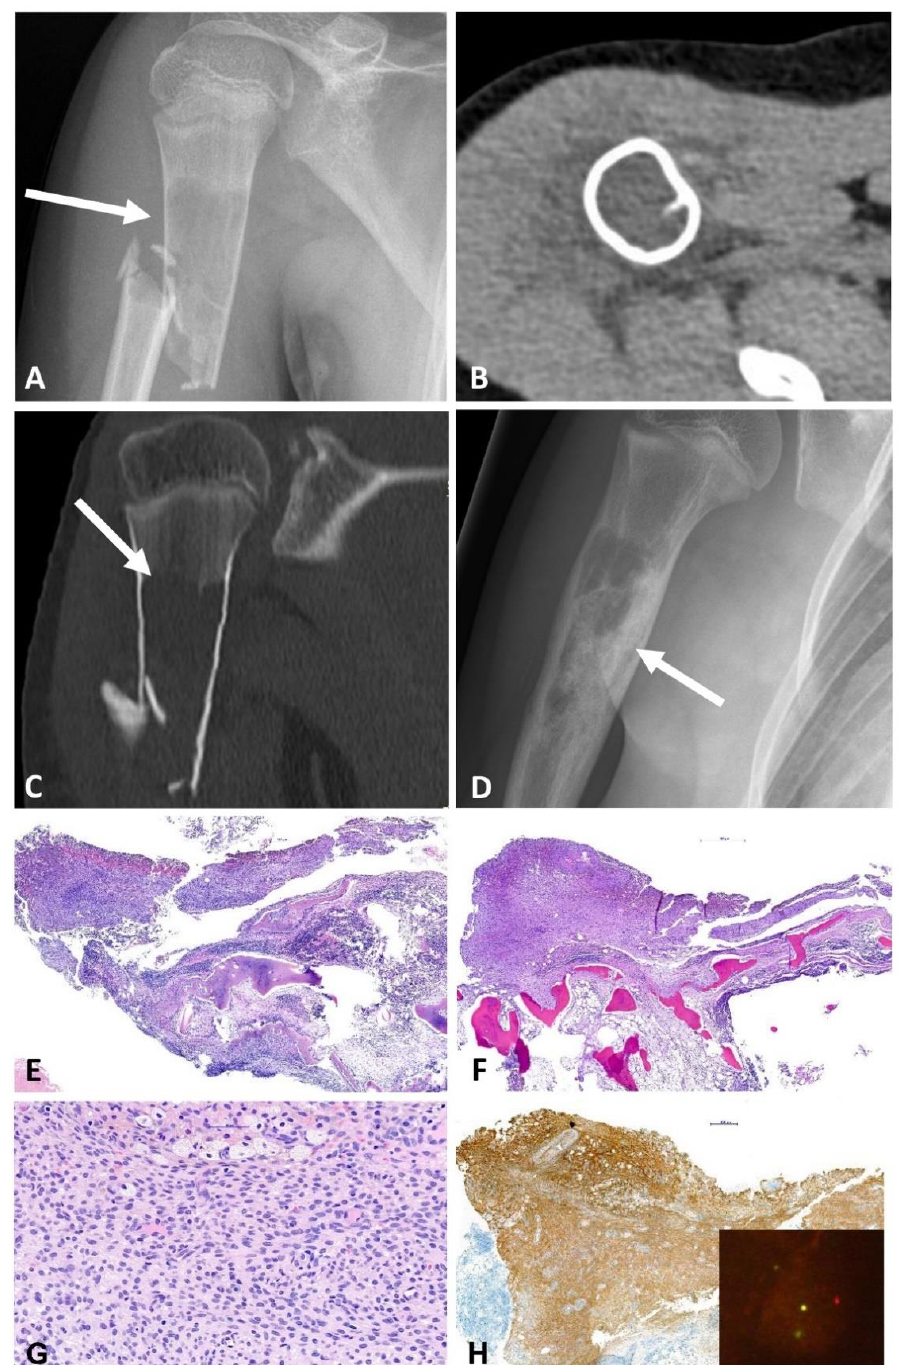
Figure 5. The 14-year-old-boy with a lytic lesion in the proximal humeral diaphysis (case #3) with a EWSR1::NFATC2 fusion. ( A ) AP radiograph shows that the tumor is central, lytic, well-circumscribed (arrow) with a thin sclerotic rim and has undergone pathological fracture. Axial soft tissue-weighted CT image ( B ) shows hyperdense intracystic content, probably caused by blood. There is circumfer- ential deep endosteal scalloping (( C ), arrow), and the margin is distinct, but not sclerotic. ( D ) Ten months after curettage, the tumor has intralesional calcifications with a thickened cortex (arrow). ( E – H ) Histologically, the cyst walls are thick and composed of woven bone and a bland monotonous proliferation of spindled and ovoid cells that have vesicular nuclei, and pale eosinophilic cytoplasm; scattered histiocytes are present. ( H ) The tumor cells are positive for CD99. FISH with EWSR1 probe reveals cells with break-apart (split) signal and no evidence of EWSR1 amplification